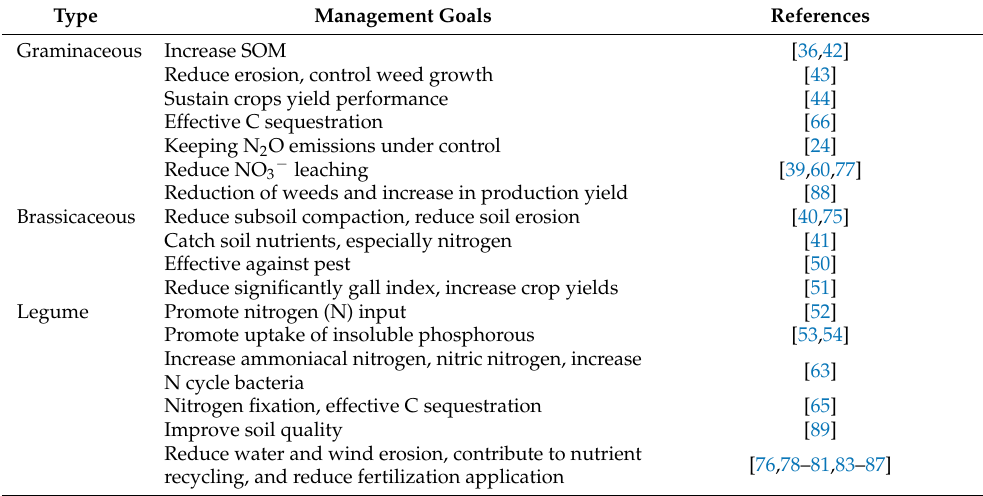
Figure 4. Benefits of cover crops on physical, chemical, and biological components of agro-ecosystems. Table 1. Agro-ecosystem services related to the use of different species of CCs.